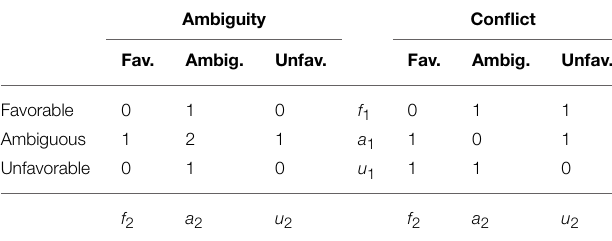
TABLE 4 | Ambiguity and conflict counts in the experienced-information setup. Ambiguity Conflict